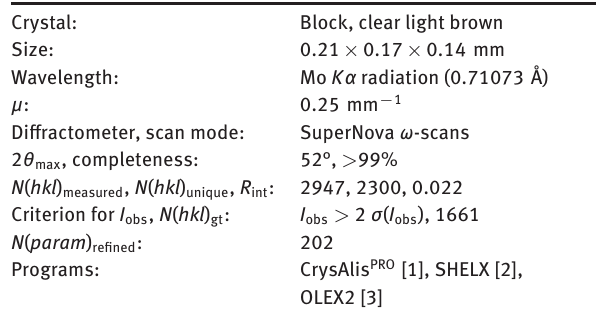
Table 2: Fractional atomic coordinates and isotropic or